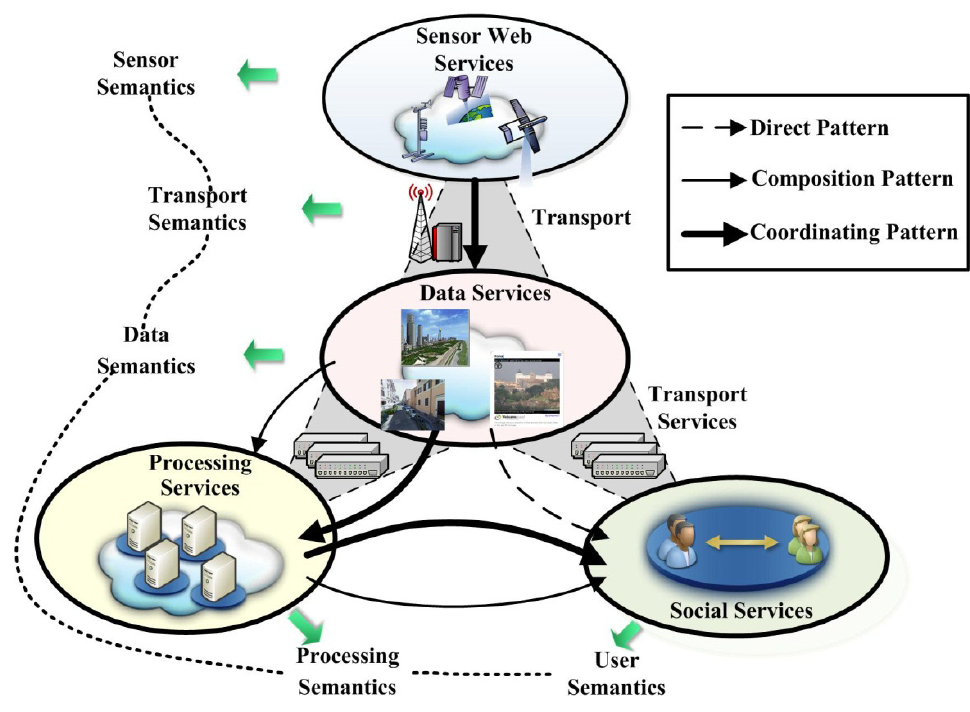
Figure 4. Service patterns in